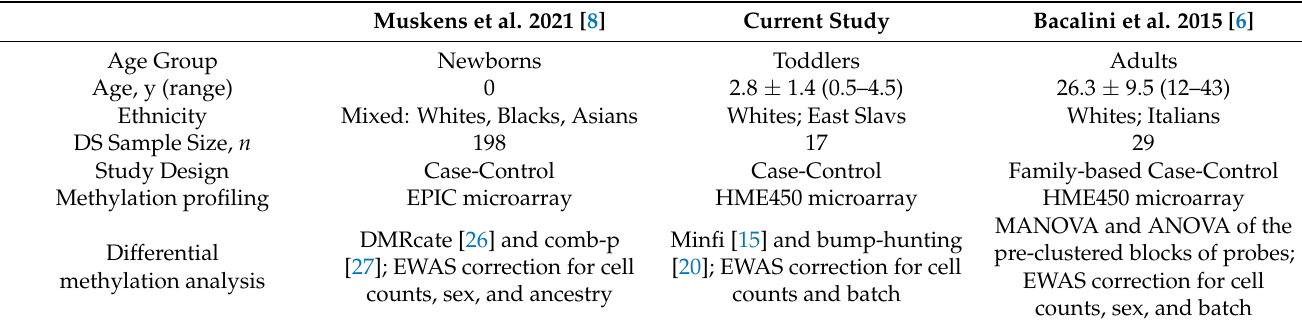
Table 1. Three datasets involved in a quasi-longitudinal analysis of DS-associated DNA methylation alterations in blood